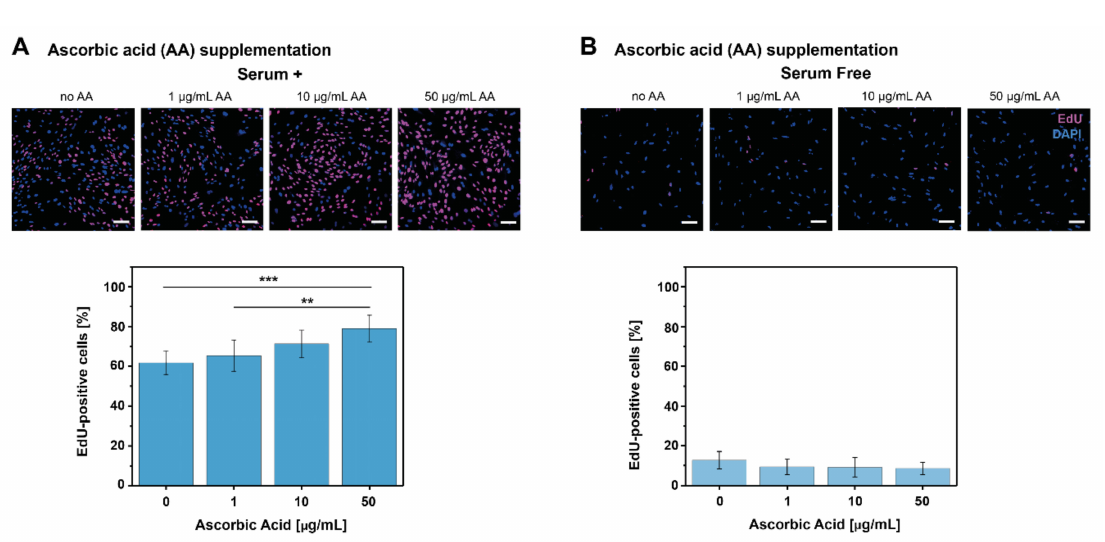
di ff erences were observed under serum + conditions for any PDGF-BB concentration (Figure S1A).